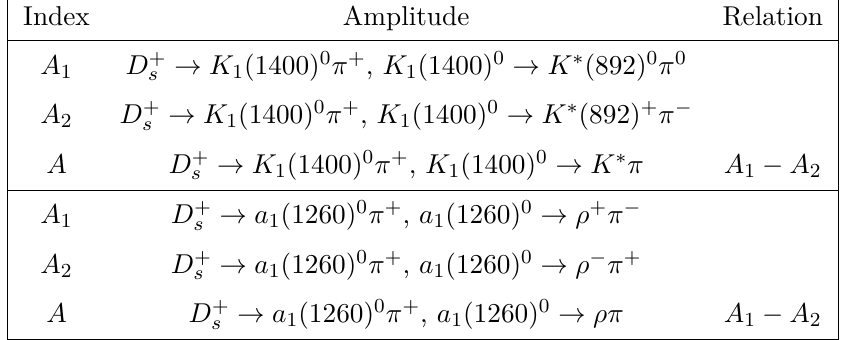
Table 13 . The Clebsch-Gordan (CG) relations